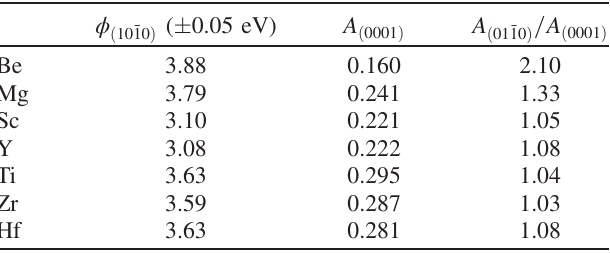
TABLE III. Photoemission properties of ( als.